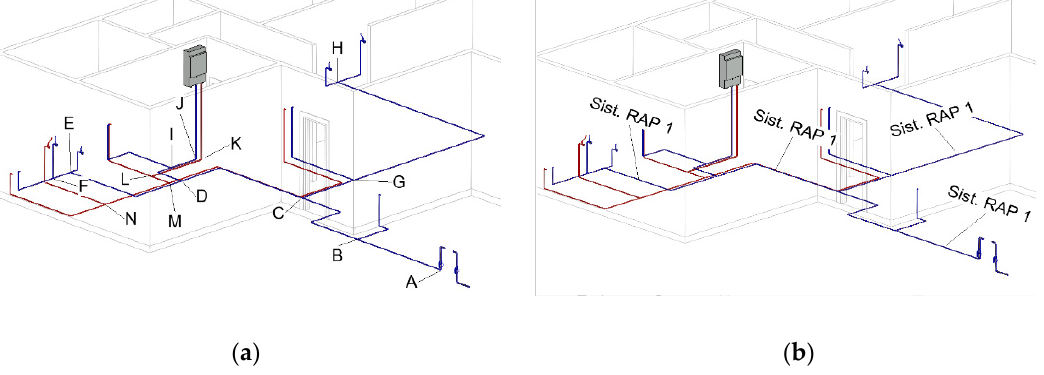
Figure 7. Results after the application of scripts 3 and 4: ( a ) node identification and ( b ) sanitary plumbing system recognition.